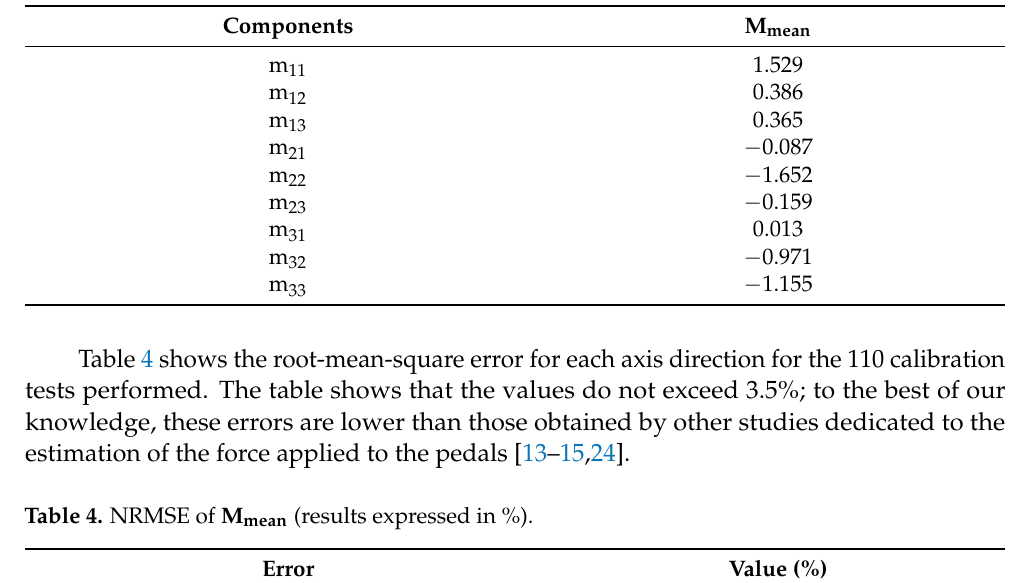
Table 3. Components of the M mean. .